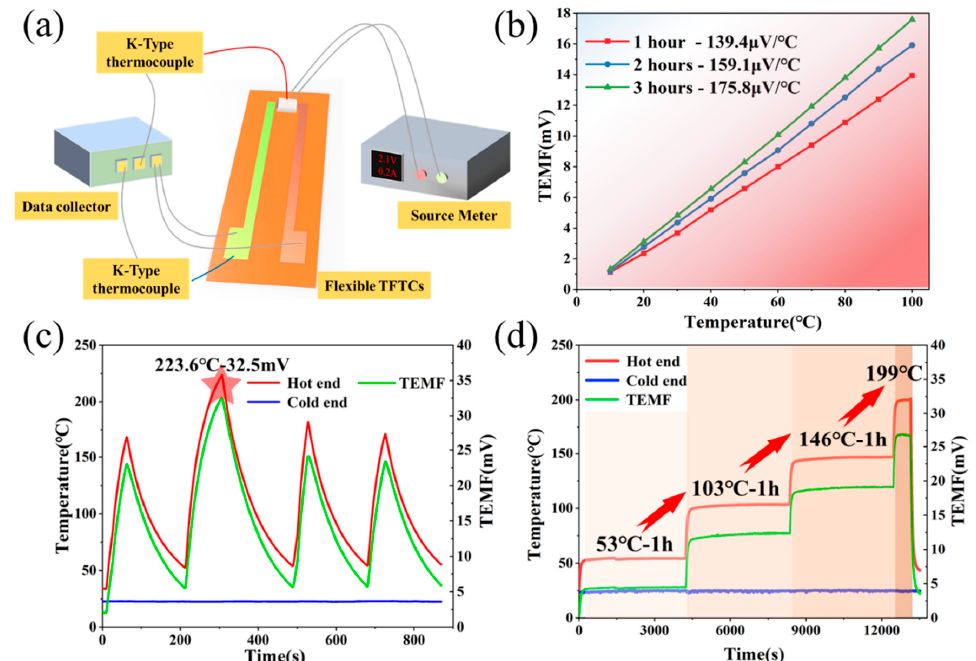
Figure 4. Comprehensive evaluation of sensor performance: ( a ) Self-designed calibration test system of sensor; ( b ) Compar- ison of the thermoelectric characteristics test of the different thermocouples (In 2 O 3 /Cu) (In 2 O 3 thermo-electrode under different heat treatment periods). The optimized sensitivity of In 2 O 3 thermo-electrode was 175.8 µ V/ ◦ C; ( c ) Evaluation of test repeatability of sensors prepared by using screen printing technology (In 2 O 3 /ITO). The highest instantaneous tempera- ture measured could be 223.6 ◦ C; ( d ) The temperature retention of the sensor that was tested at different temperatures. The heat preservation test was performed at 53 ◦ C, 103 ◦ C and 146 ◦ C, respectively, for up to 1 h. Besides, a short-term test of 10 min was performed at around 199 ◦